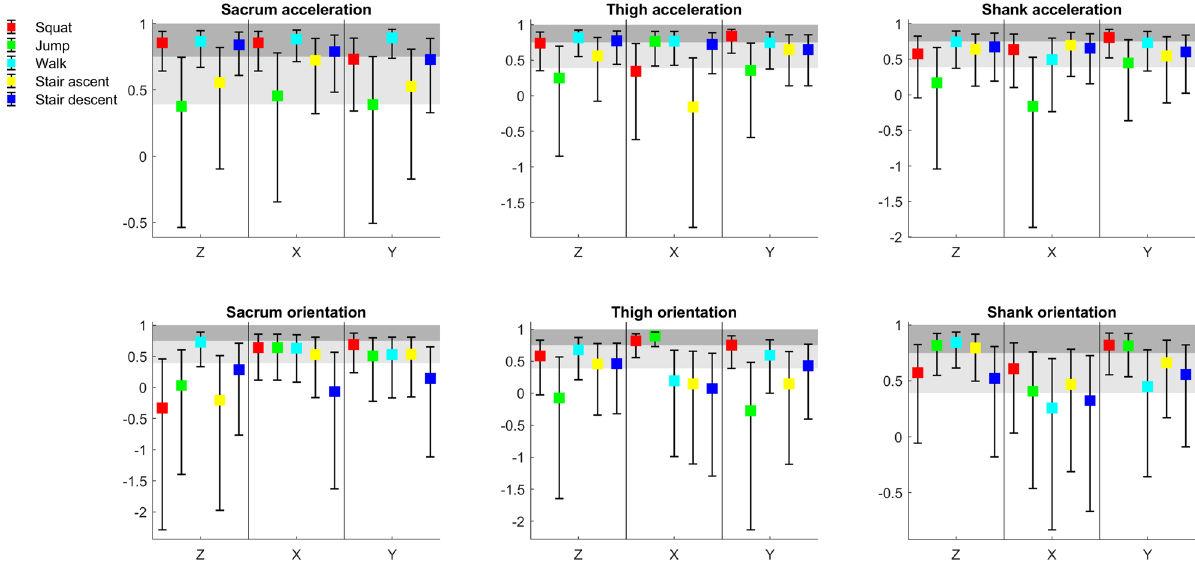
Figure 7. ICCs (95% CI) for acceleration and orientation range values (session 1 vs. session 3); light grey shaded areas indicate fair-to-high test–retest reliability; dark grey shaded areas indicate excellent test–retest reliability.